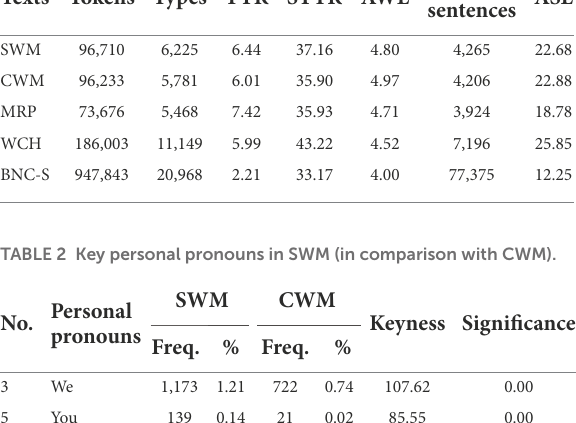
TABLE 1 Macro-linguistic statistics of different types of spoken texts.